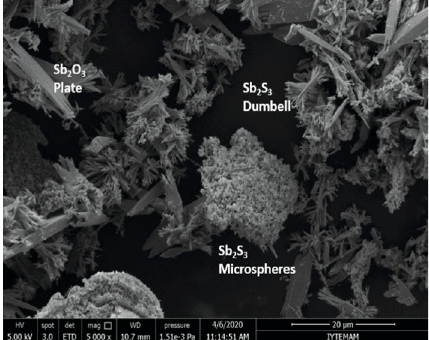
Figure 3: SEM image of the reference prepared by re fl uxing of SbCl and Na S · 3H O in 18h. The magni fi cation is 5000x. 3 2 2